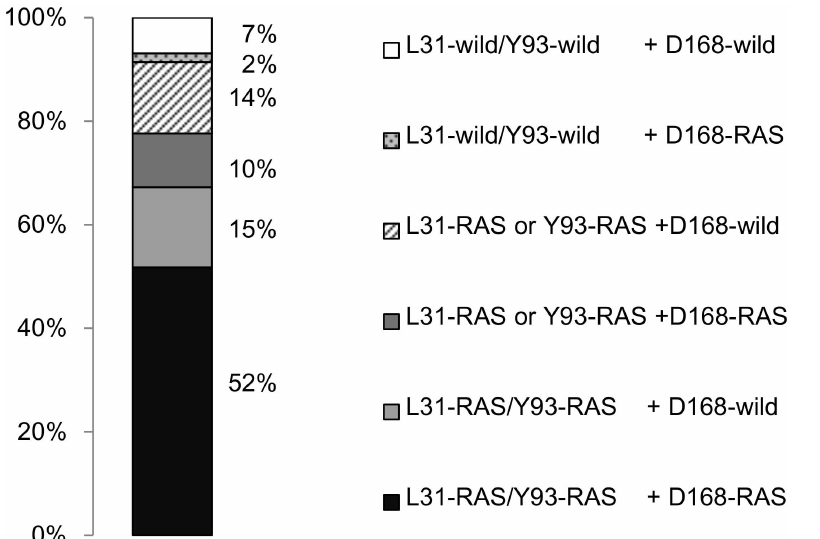
Fig 6. Co-existence of signature RASs in NS3 and NS5A. The prevalenceof co-existence of signature RAS in NS3 and NS5A was analyzed.The prevalenceof concomitant D168 RAS with L31 and/or Y93 RAS was